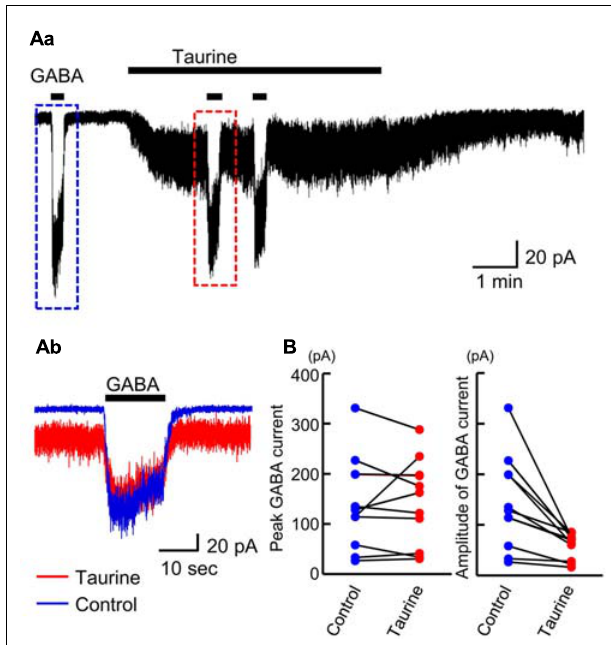
FIGURE 10 | Comparison of GABA-evoked currents before and during taurine application in radially migrating neurons in the SP region of the fetal neocortex. (Aa) Typical trace of the currents evoked via the puff application of 10 μ M GABA before and during bath perfusion of 10 mM taurine in a single RFP-positive neuron.The GABA-evoked currents boxed with dashed colored lines were superimposed in (Ab) . V H was − 60 mV. (B) The peak levels of GABA-evoked currents before (Control) and during taurine application (Taurine) are plotted and compared (left, n = 10).The levels were not significantly altered by taurine application ( P = 0.867 by paired t -test).The amplitudes of GABA-evoked currents before (Control) and during taurine application (Taurine) are plotted and compared (right). The amplitudes were significantly altered by taurine application ( P = 0.004 by paired t